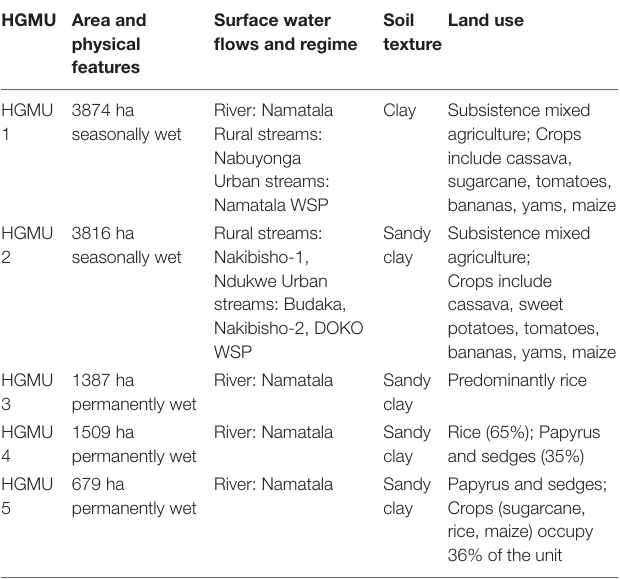
TABLE 1 | Characteristics of the hydrogeomorphic units (HGMUs) in Namatala Wetland. HGMU Area and